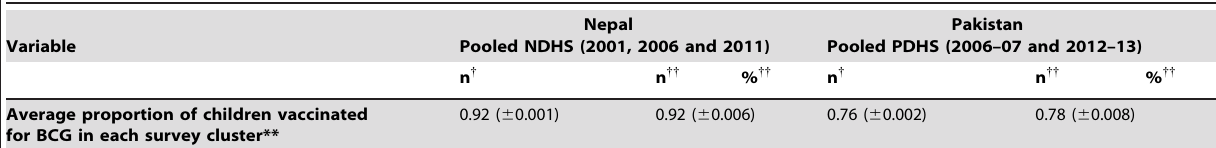
Variable Average proportion of children vaccinated for BCG in each survey cluster** { Unweighted. {{ Weighting was applied to compensate for the multistage cluster sampling design. *included Gilgit and Islamabad regions. **Mean ( 6 SD) BCG: Bacillus Calmette-Guerin. CI: Confidence interval. NA: Not applicable. NDHS: Nepal Demographic and Health Survey. PDHS: Pakistan Demographic and Health